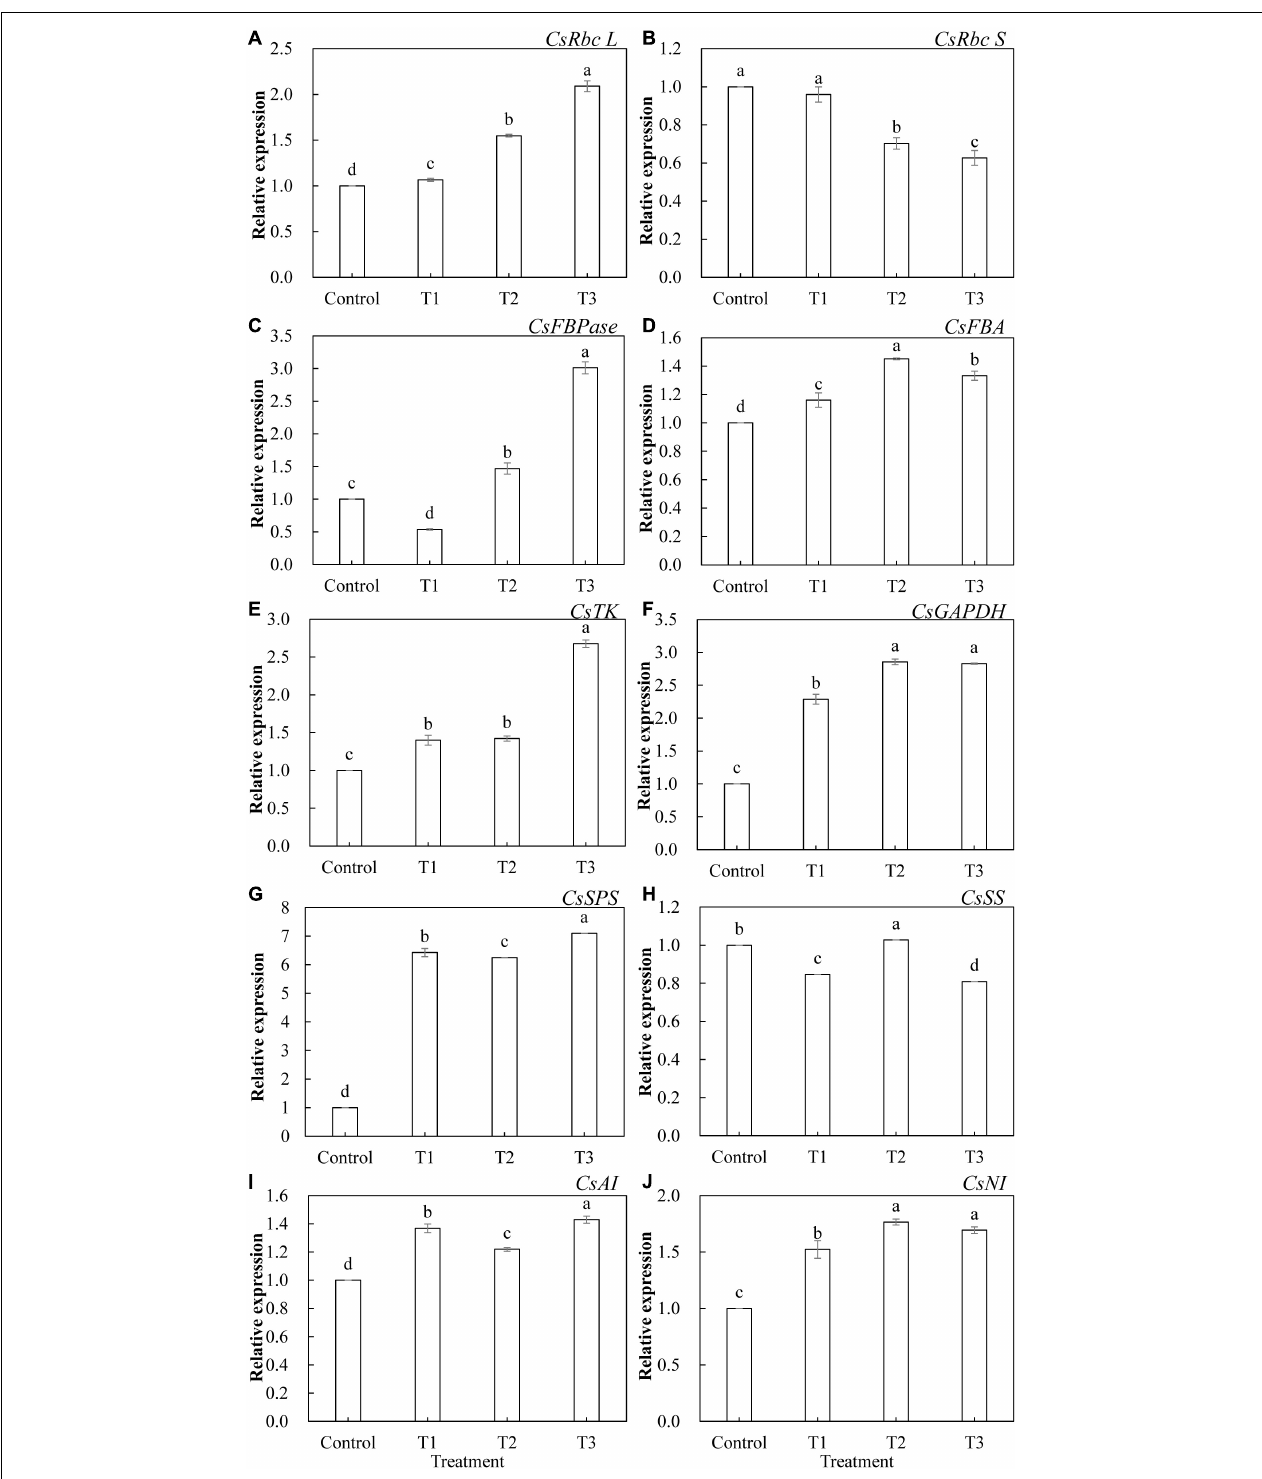
FIGURE 9 | Effects of supplemental LED light duration on the expression levels of CsRbc L (A) , CsRbc S (B) , CsFBPase (C) , CsFBA (D) , CsTK (E) , CsGAPDH (F) , CsSPS (G) , CsSS (H) , CsAI (I) , and CsNI (J) in cucumber leaves. After LED light treatment for 30 days, 10 cucumber leaves were selected from the third leaf from the top in each treatment, washed and dried immediately, and then placed in liquid nitrogen. They were stored in a refrigerator at –80 ◦ C for total RNA extraction and subsequent qRT-PCR experiments. Values are expressed as mean ± SE ( n = 3). Bars that are significantly different based on the Duncan’s multiple range test ( p < 0.05) are indicated with different lowercase